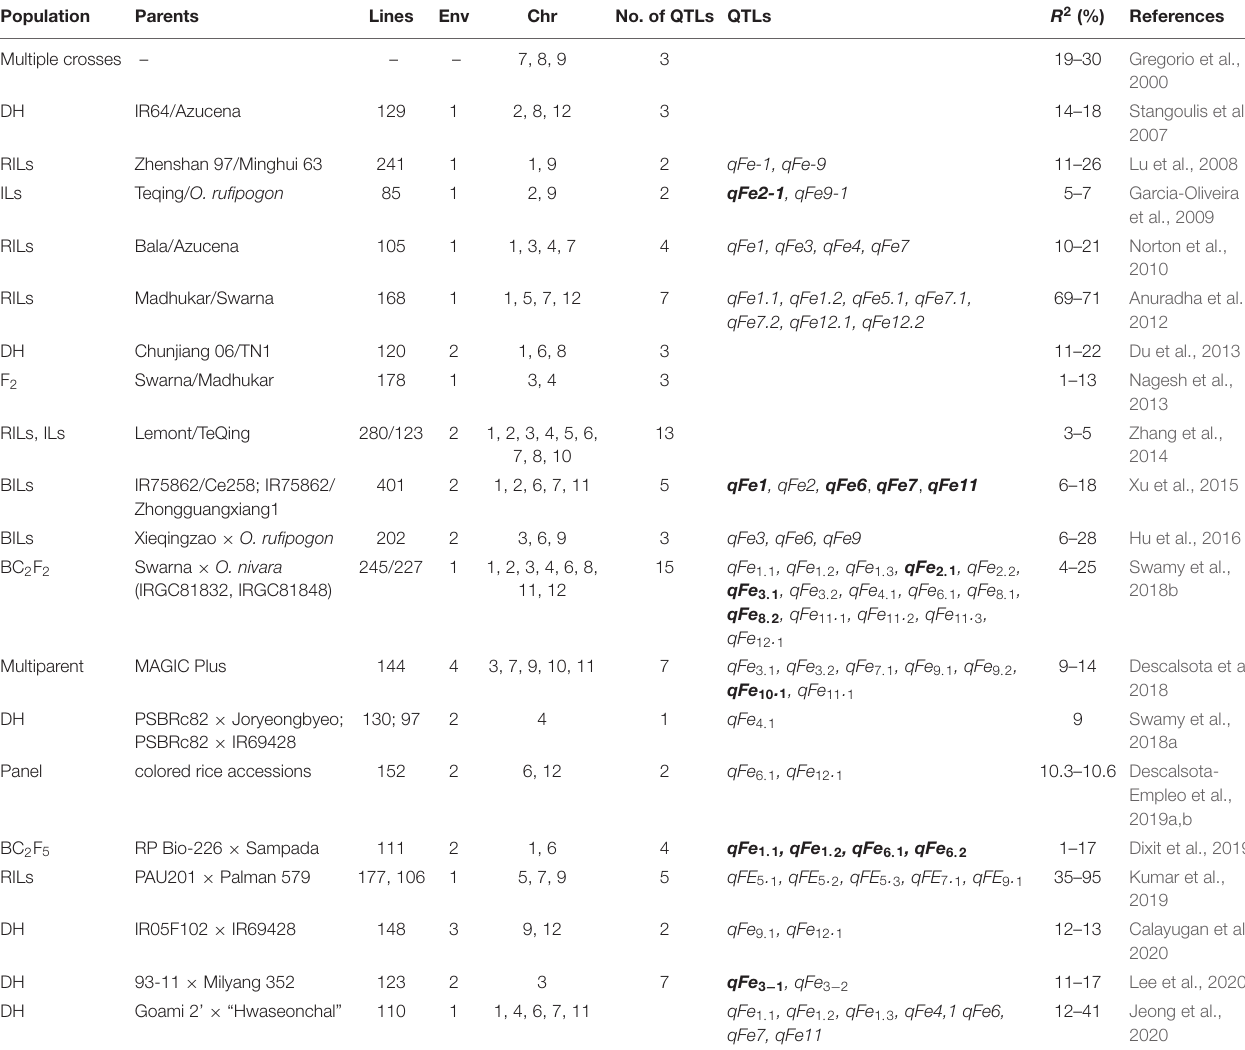
TABLE 1 | List of QTLs and candidate genes reported for iron concentration in rice.